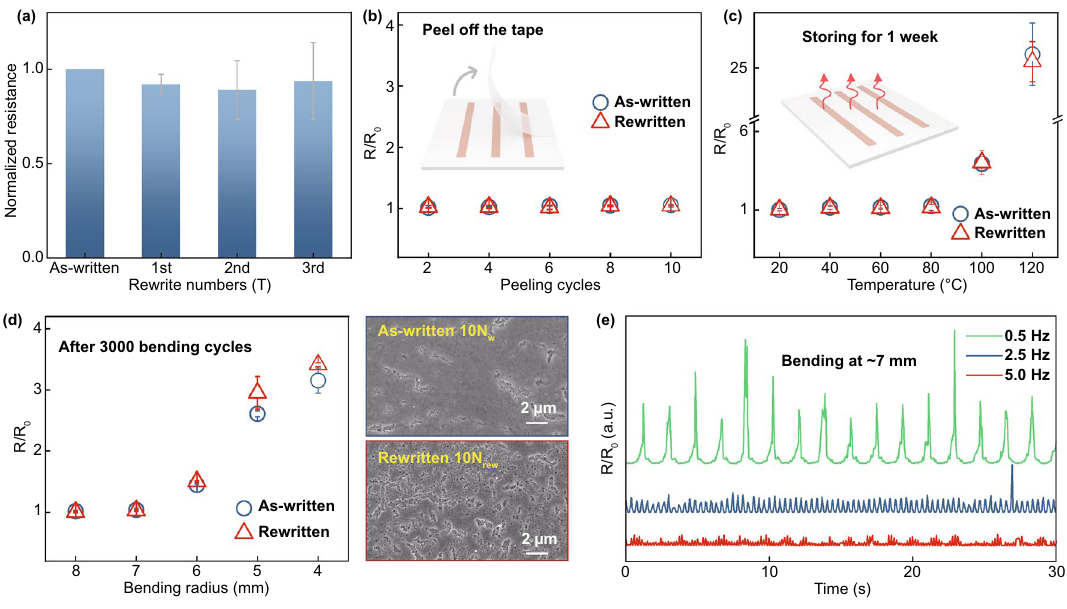
Fig. 4 Electrical performance and stability of the first-written and rewritten structures. a Normalized resistance changes of the structures as a function of rewritten numbers. Relative resistance changes of the structures after b adhesion testing, c thermal stability testing, and d bending testing. Insets in d are the surface morphologies of the as-written and rewritten patterns. Both the N w and N rew are 10. e In situ relative resistance changes of the typical pattern during the bending cycles. Different in R / R 0 value is because the change rate exceeds the 0.04 s sampling